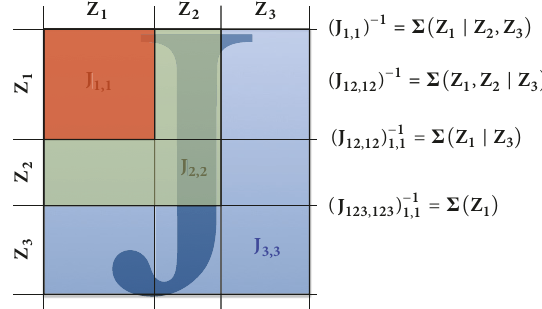
Figure 4: The inverse of parts the inverse covariance J gives the covariance of the variables corresponding to that part conditioned to the other